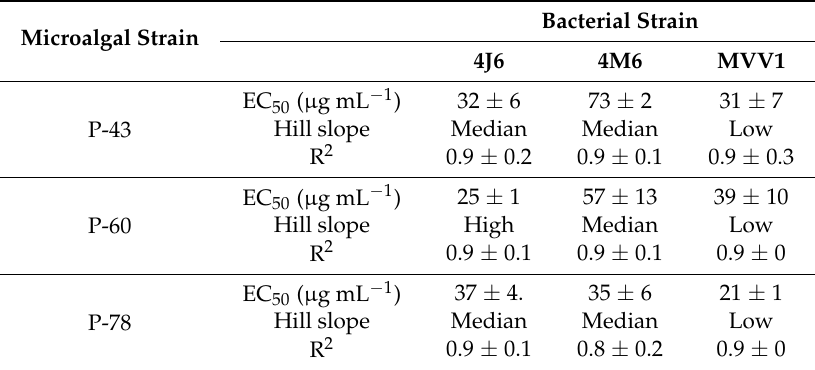
Table 4. Effect of selected microalgal extracts on the adhesion of a selection marine bacteria. R 2 corresponded to the fitting quality for the dose response curve (>0.8). Microalgal Strain